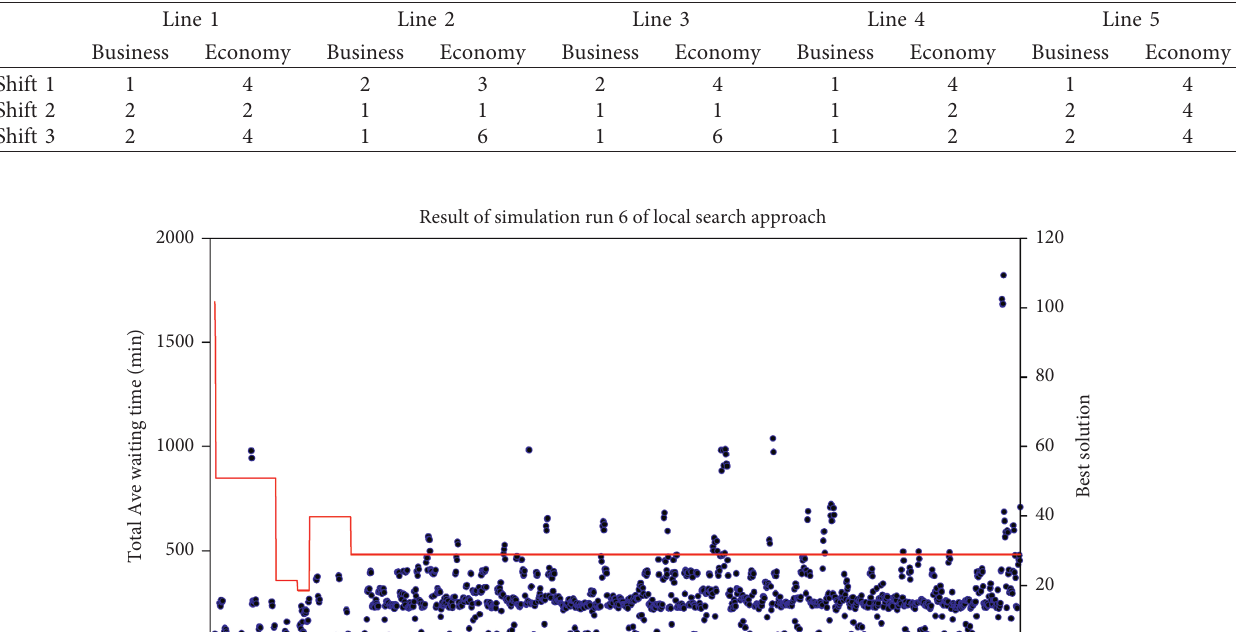
Table 4: Check-in additional resource results using the random technique.